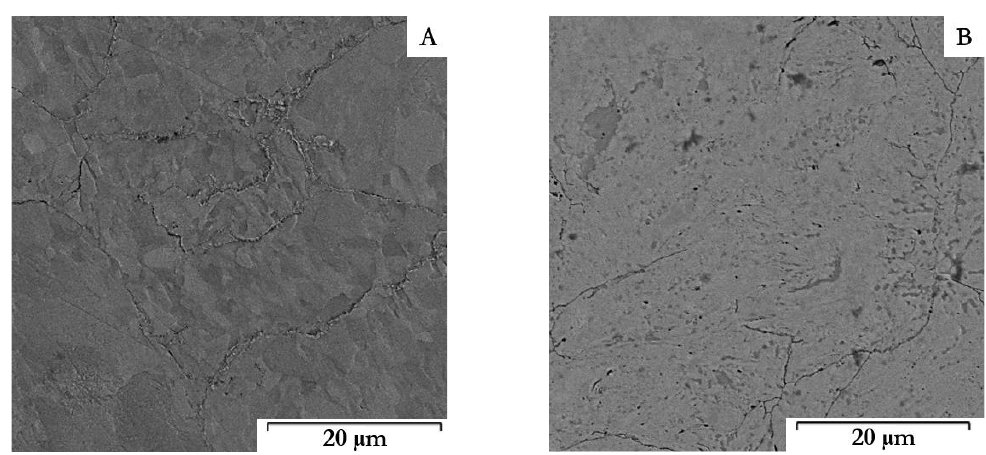
Figure 2. Powder particles: ( A ) Zn, ( B ) Zn – 1Mg – 0.5Sr .